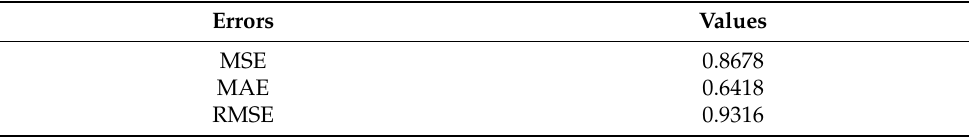
Figure 11. ( a ) Error and ( b ) relative error of solar radiation modeled by ARMA (3,3) (for a summer day). Table 5. MSE, MAE, and RMSE of the prediction of solar radiation using ARMA (3,3) (summer day). Errors Values MSE 0.8678 MAE 0.6418 RMSE 0.9316